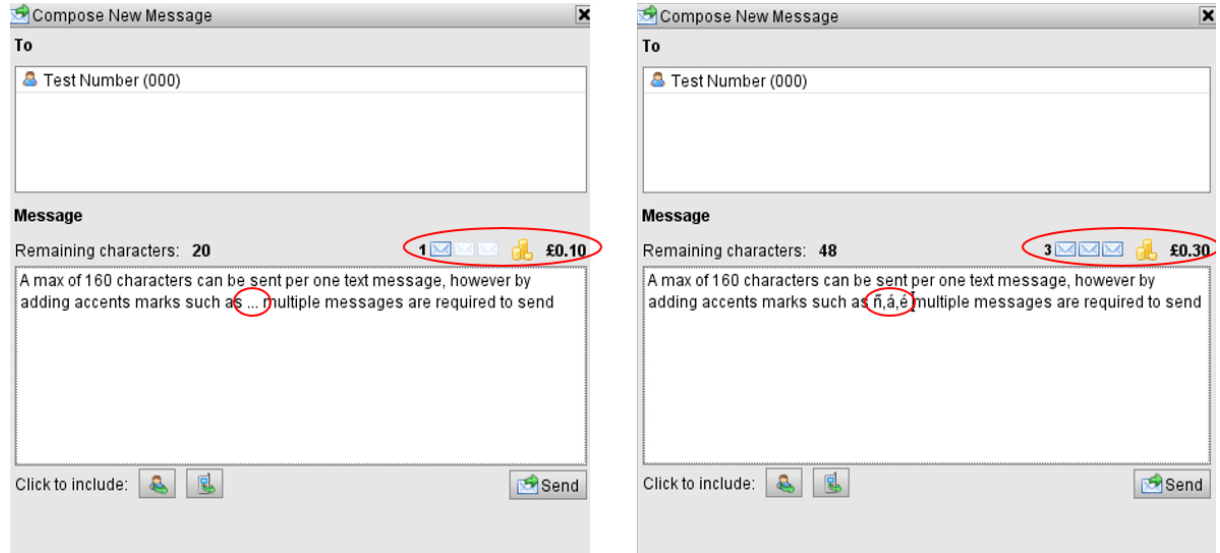
Figure 2. Number of texts and associated costs without (left) and with (right) accent